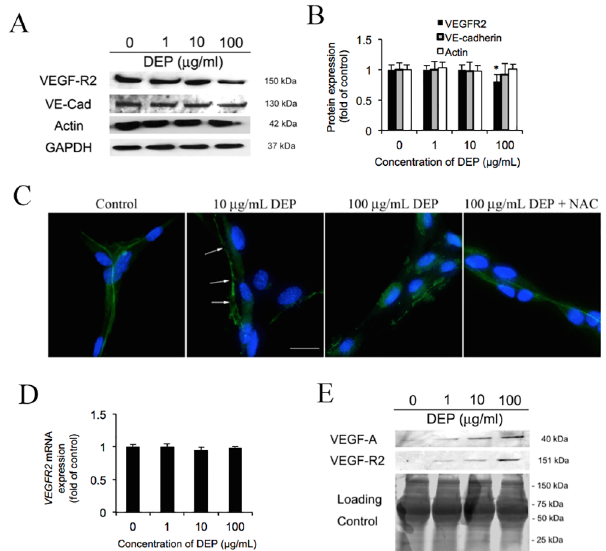
Fig 7. DEP dissociate VEGF-R2 from adherens junction connection. (A) After 24 h DEP (1, 10 and 100 g/ mL) exposure, the tube cells were lysed and harvested. The untreated cells (0 g/mL) were defined as negative control. The level of adheren junctional proteins VEGF-R2, VE-cadherin (VE-Cad), -catenin and cytoskeleton actin were determined by Western blot. Equal amount of protein loading was confirmed based on total GAPDH expression. (B) Quantification showed VEGF-R2 decrease in a dose dependent manner as the relative fold change to the control. Again, the level of VE-cadherin, -catenin and cytoskeleton actin activities are unaffected by DEP. (C) Images show the distribution of VEGF-R2 in response to DEP (10 and 100 g/mL) and DEP (100 g/mL) plus NAC exposure for 24 h. Nuclei were stained with 10 mM DAPI. Shown is a representative image from three independent experiments. Scale bar = 10 m. Magnification is 400X. (D) To confirm whether DEP change VEGF-R2 expression, the cDNA were probed with VEGFR2 primers and the activity were analyzed using QPCR after exposure with DEP for 24 h. The level of mRNA normalized to 18s gene expression was presented as the fold change relative to the untreated control (0 μ g/mL). Means ± SD, n = 3. (E) Effects of DEP on the secretion of VEGF-R2. Secretion of VEGF-R2 of capillary tube cells related to the DEP exposure. After 24 h DEP (1, 10 and 100 g/mL) exposure, the supernatant/medium were